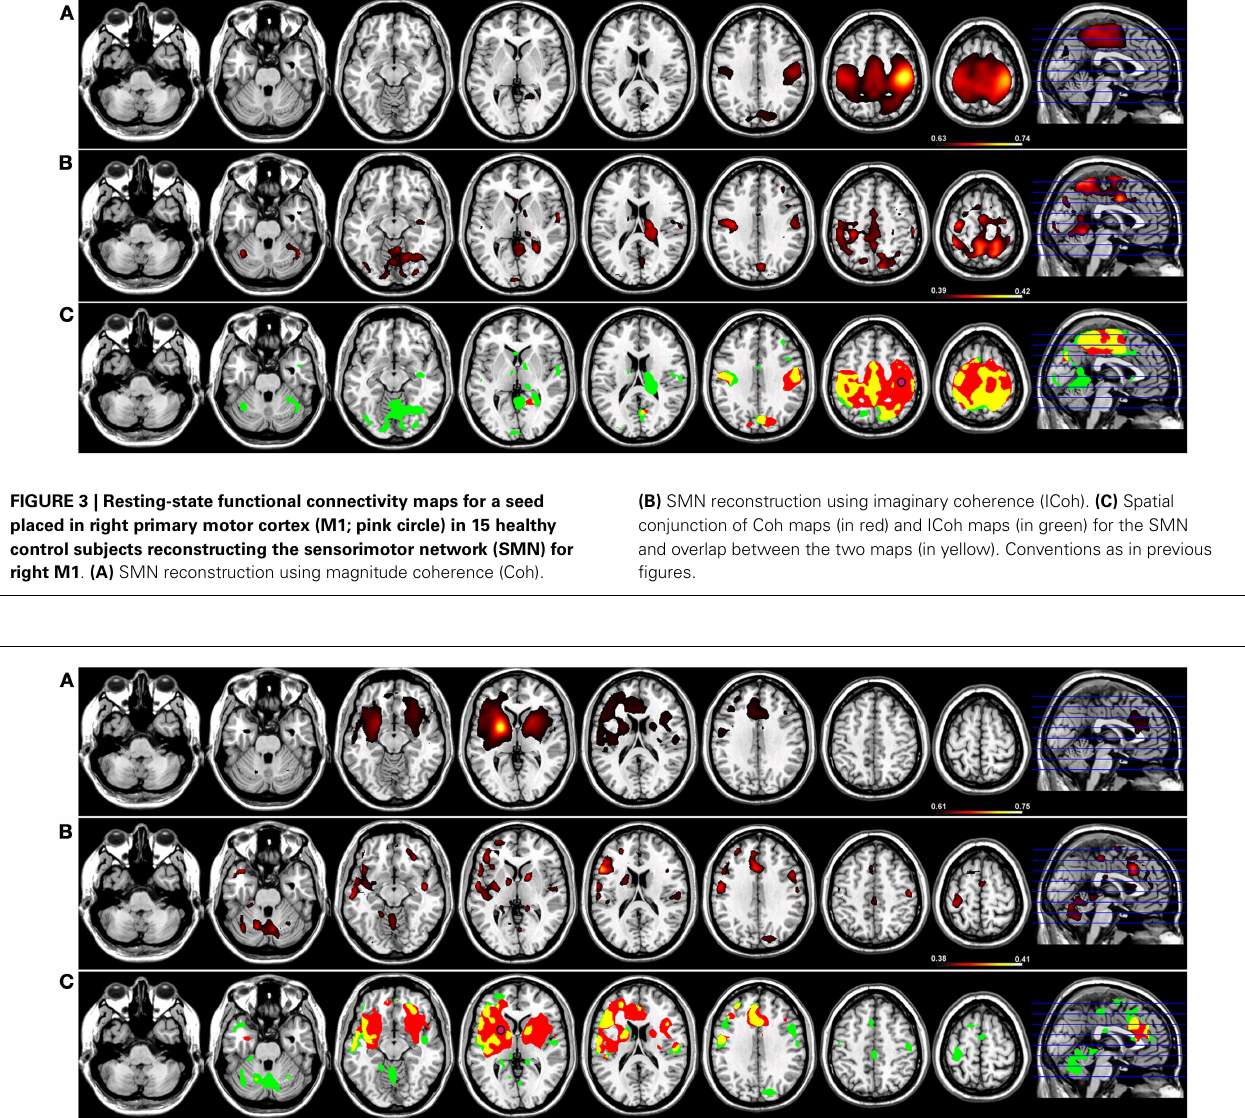
reconstruction using imaginary coherence (ICoh). (C) Spatial conjunction of Coh maps (in red) and ICoh maps (in green) for the BGN and overlap between the two maps (in yellow). Conventions as in previous